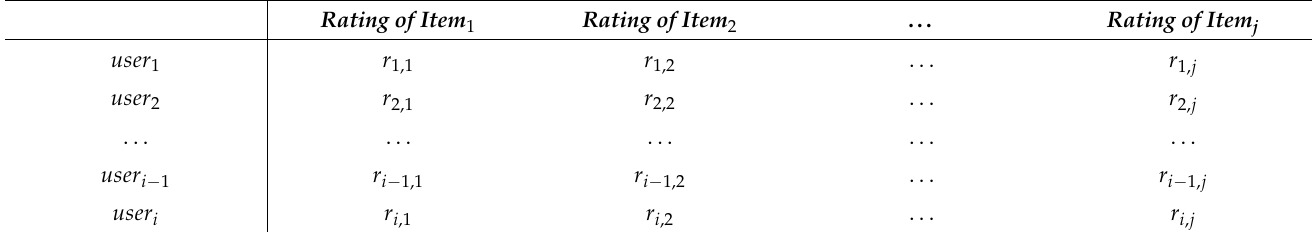
Table 3. Actual user rating data.